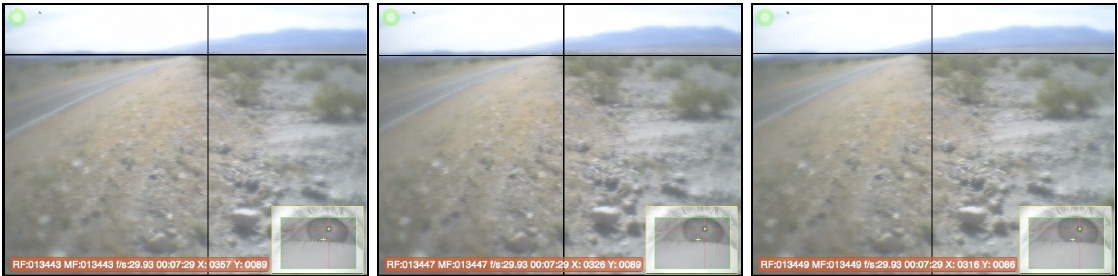
Figure 15. Effect of head motion compensation during slow head rotation. Shown above are median frames from three separate fixations that were detected when head motion compensation was not applied; with head motion compensation, these were combined into a single